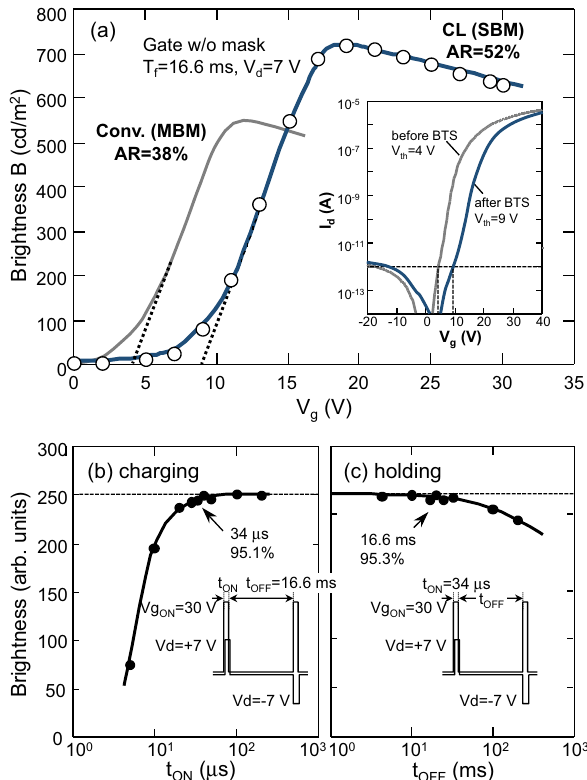
Figure 4. ( a ) Dependence of panel brightness and TFT current on gate voltage for the conventional pixel structure of 38% aperture ratio (AR) with matrix black matrix (MBM) over both drain and gate lines and proposed CL pixel structure of 52% AR with strip black matrix (SBM) over only the drain lines. Transfer characteristics before and after bias temperature stress (BTS) treatment are shown in the inset. ( b ) Charging and ( c ) holding characteristics of enhanced TFT of the CL structure with gate as a common line. Vg and Vd in the TFT ON state are 30 V and +/−7 V,